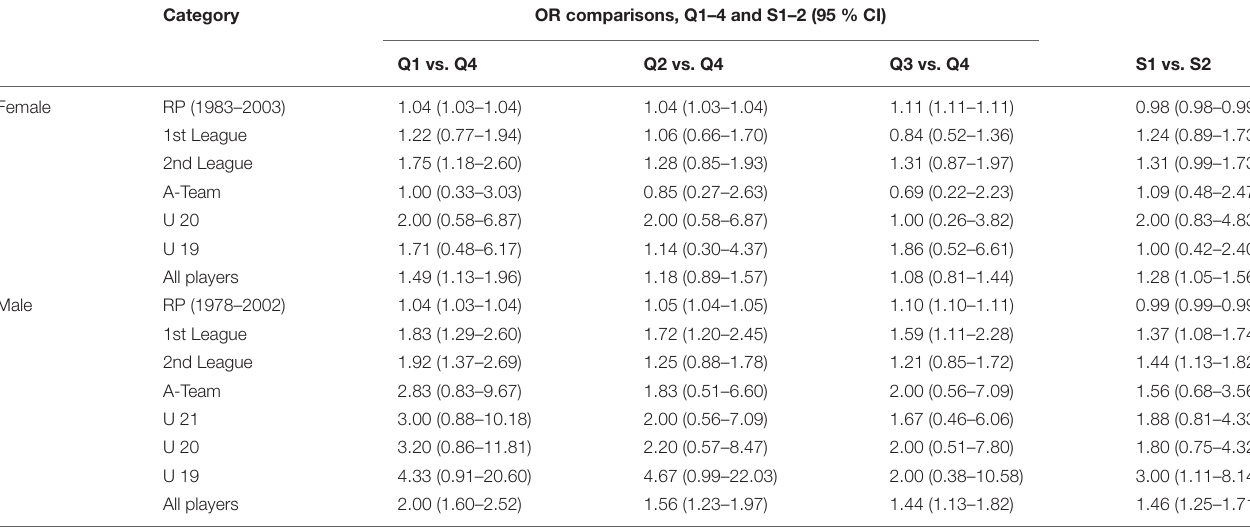
TABLE 3 | Odds ratios of the birthdate distribution for the female and male elite adult soccer